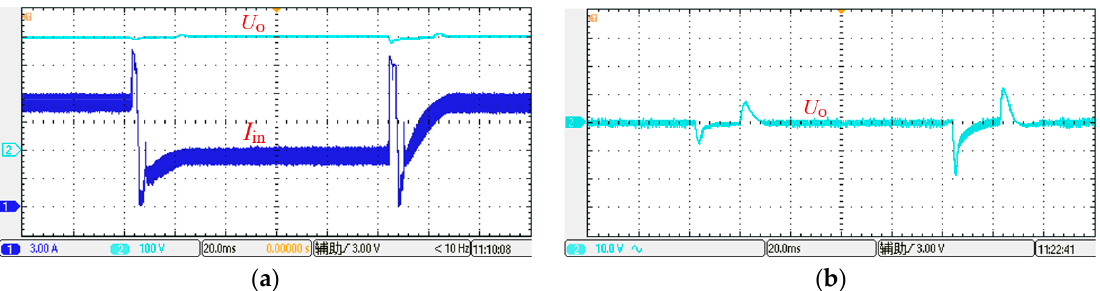
Figure 17. The output voltage and input current waveforms of converter during 50% load disturbance experiment. ( a ) The converter output voltage (oscilloscope DC coupling mode) and input current; ( b ) the converter output voltage (oscilloscope AC coupling mode).